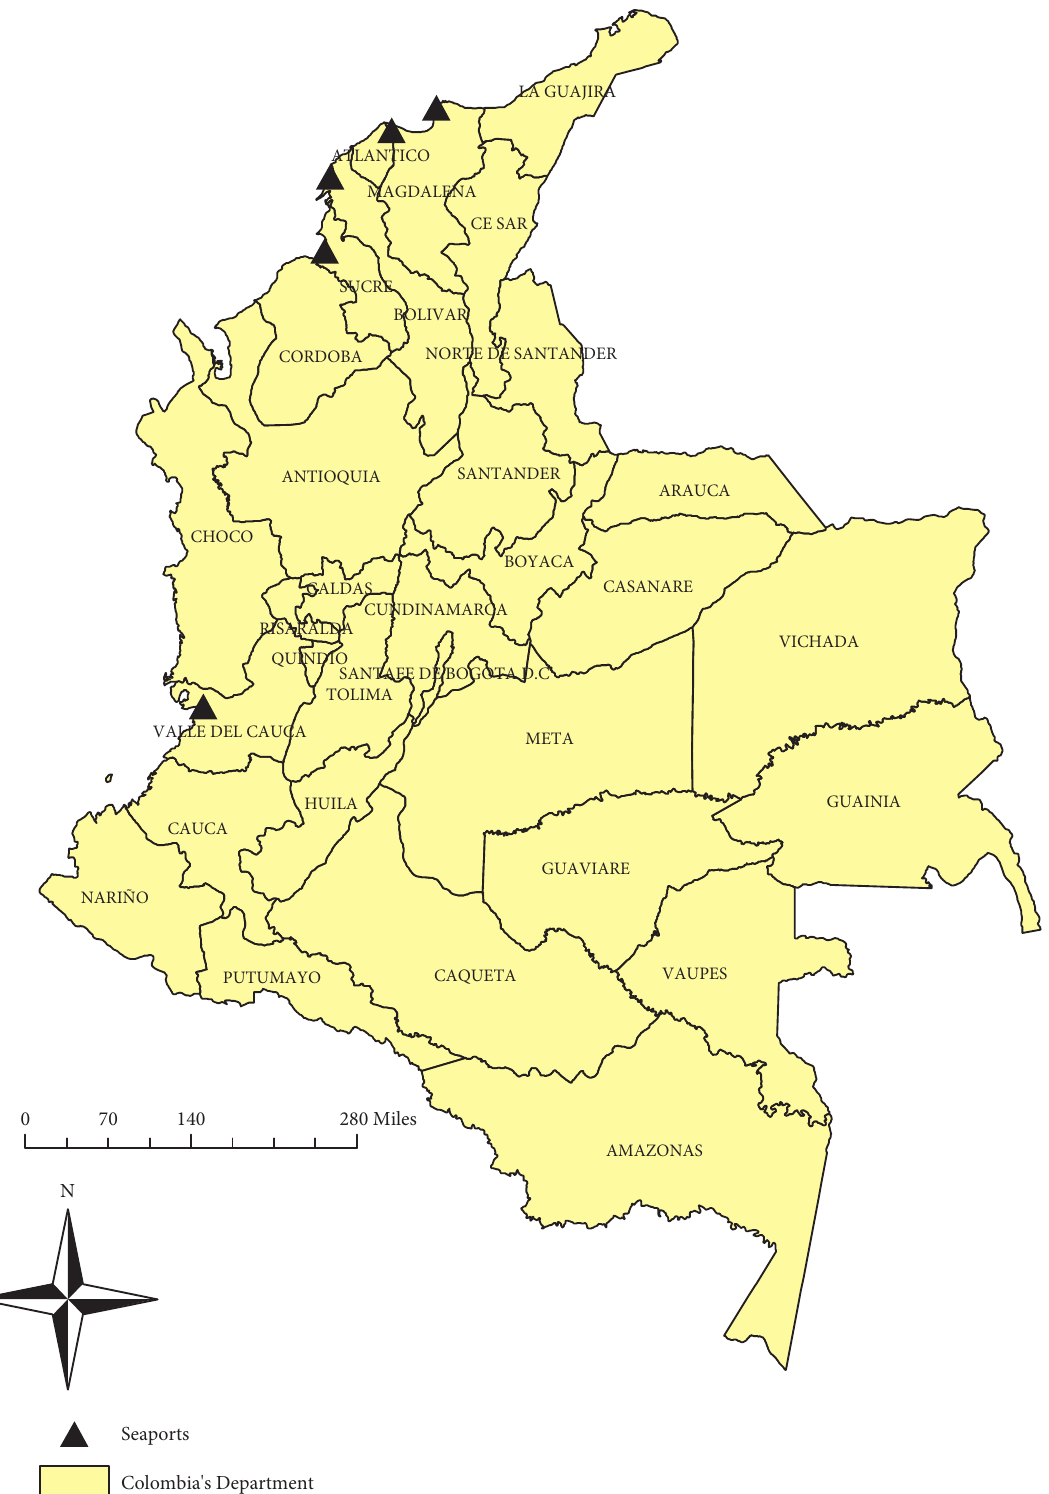
Figure 1: Colombian